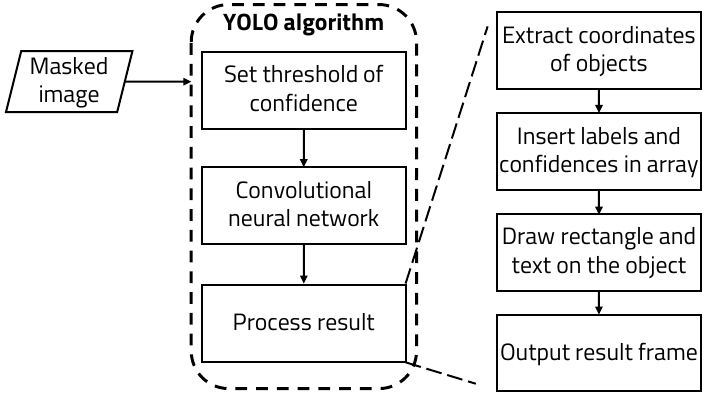
Figure 9. YOLO algorithm for object detection.